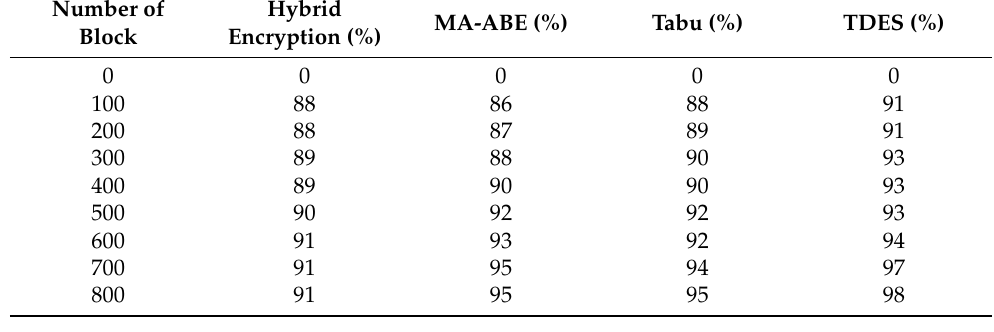
Number of Block Hybrid Encryption (%) MA-ABE (%)